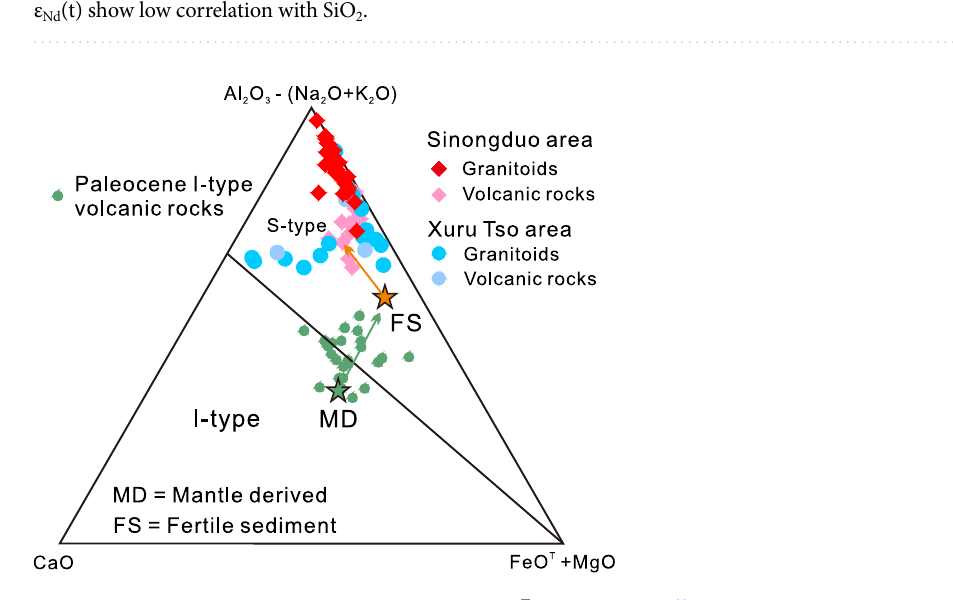
Figure 7. Al 2 O 3 -(Na 2 O + K 2 O) versus CaO versus FeO T + MgO diagram 23 . Data for the Paleocene I-type volcanic rocks are Mo et al. 5,6 , and Lee et al. 9